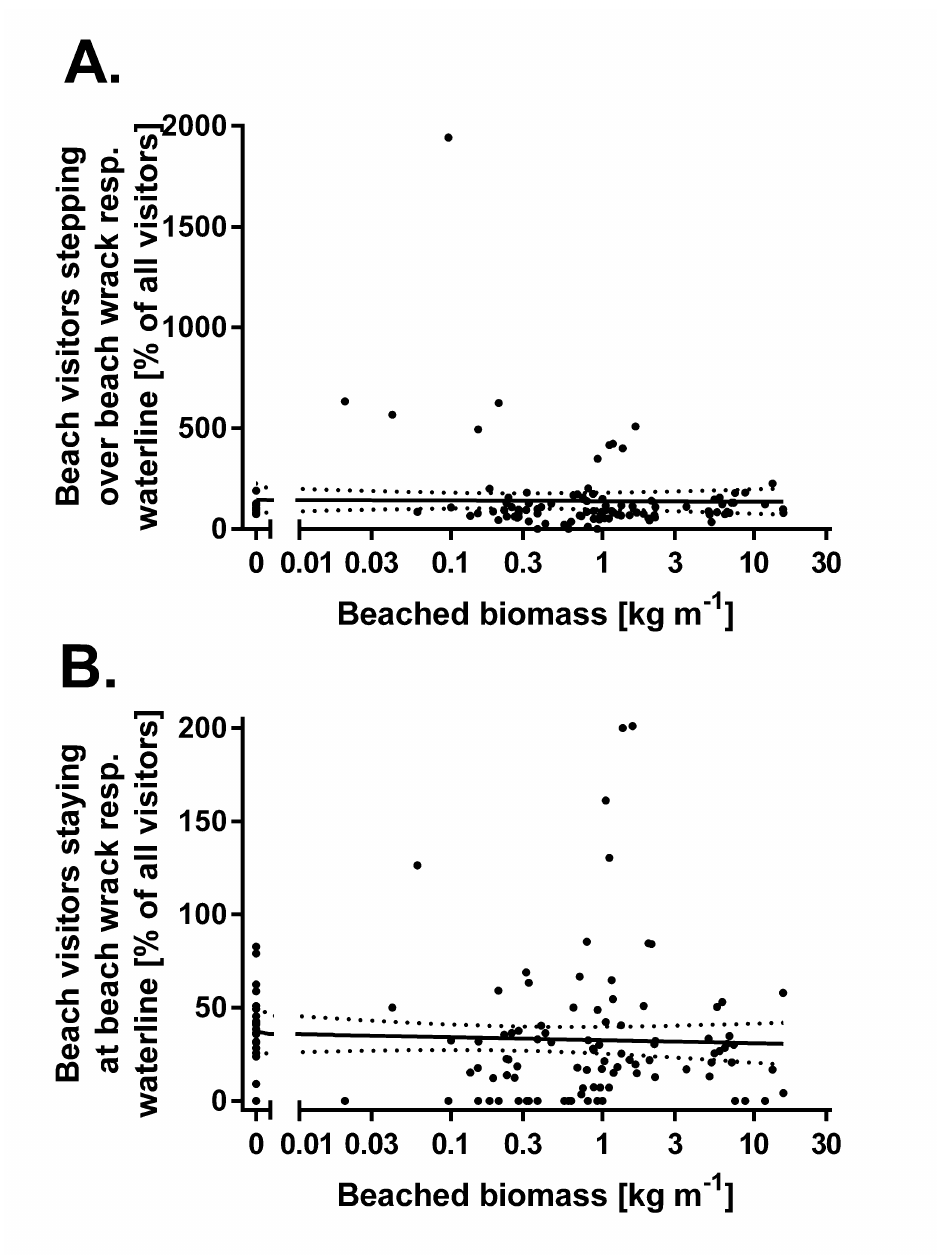
Figure S4 : Effect of Zostera beach wrack density on (A.) the frequency of beach visitors crossing the beach wrack and (B.) the frequency of these visitors staying in direct vicinity of the beach wrack for 30 s or more time. Alltogether 118 repeated measurements were conducted during two consecutive days in time intervals of 30 min on six different beach sections at Eckernförde and biomass densities were determined in parallel. Lines represent best fitting linear functions (calculated in B. from the logarithmic biomass density and the non-logarithmic effect size and in A. from the double-logarithmic dataset), dotted lines indicate their 95 % confidence